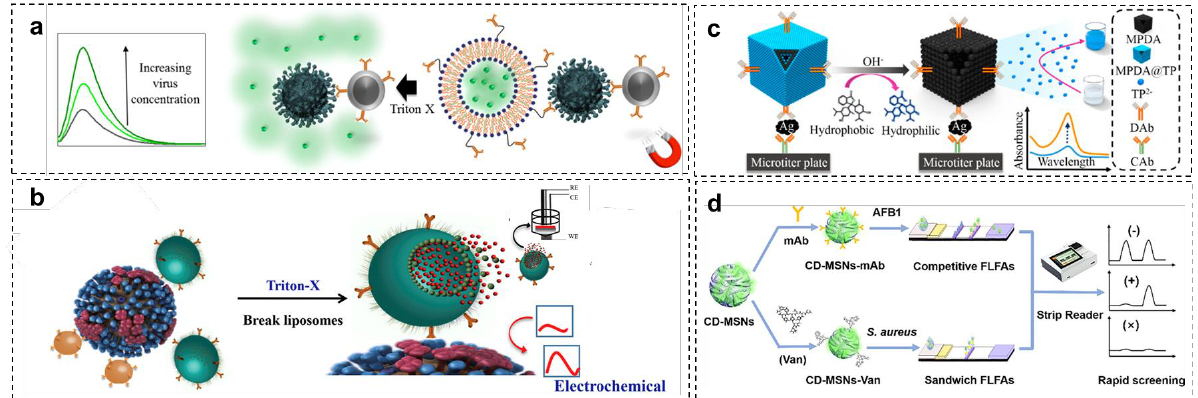
Figure 2. The illustration of various nanosphere-based sensing techniques for virus detection. ( a ) Illustration of target−specific liposome and magnetic nanoparticle conjugation for the amplified flu- orescent−based detection of Norovirus. ( b ) Illustration of liposome−based dual signal amplification technique for ultrasensitive Norovirus based on optical and electrochemical detection. ( c ) Illustra- tion of metal−polydopamine framework as signal−generation tag for colorimetric immunoassay. ( d ) Illustration of lateral flow immunoassay platform based on carbon−dots embedded mesopor ous sil- icon nanoparticles fluorescent reporter probes. Adapted with permission from [10,12,23,24] . Cop- 2023,